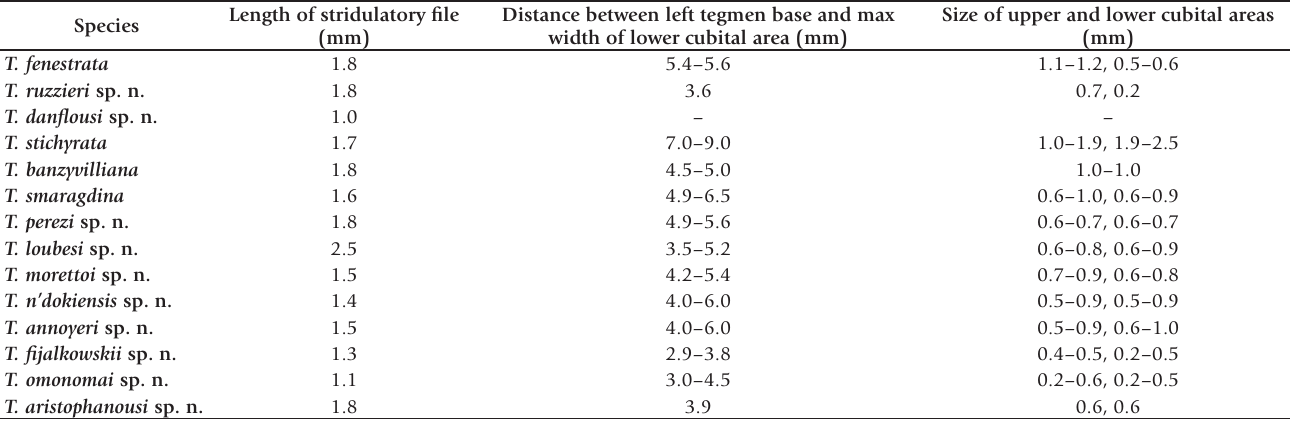
Size of upper and lower cubital areas